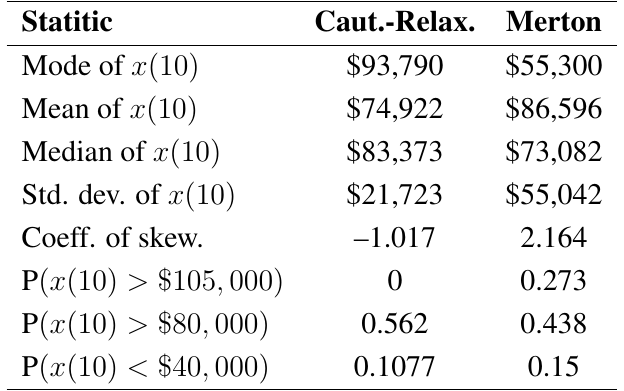
Table 1. Merton and cautious-relaxed pension yield distribution